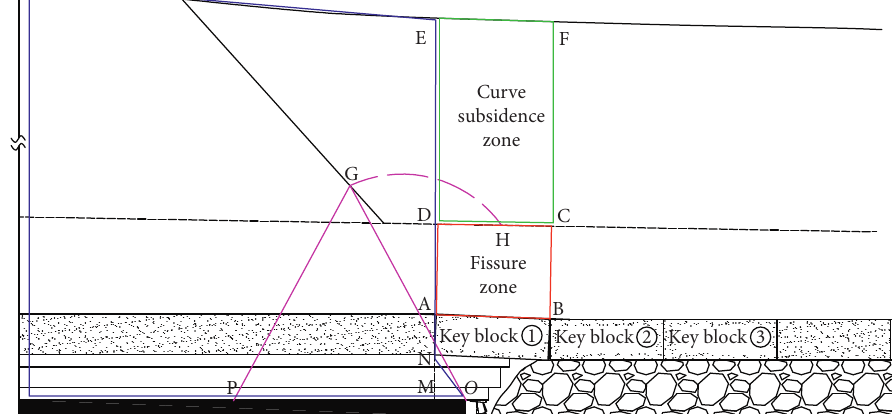
Figure 4: Mechanical model of the distribution of abutment pressure on the long-wall mining face.